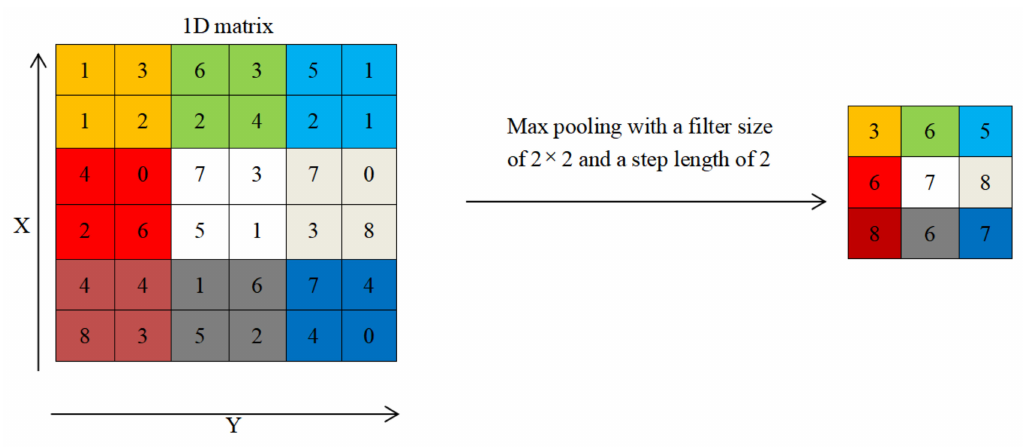
Figure 5. The max pooling